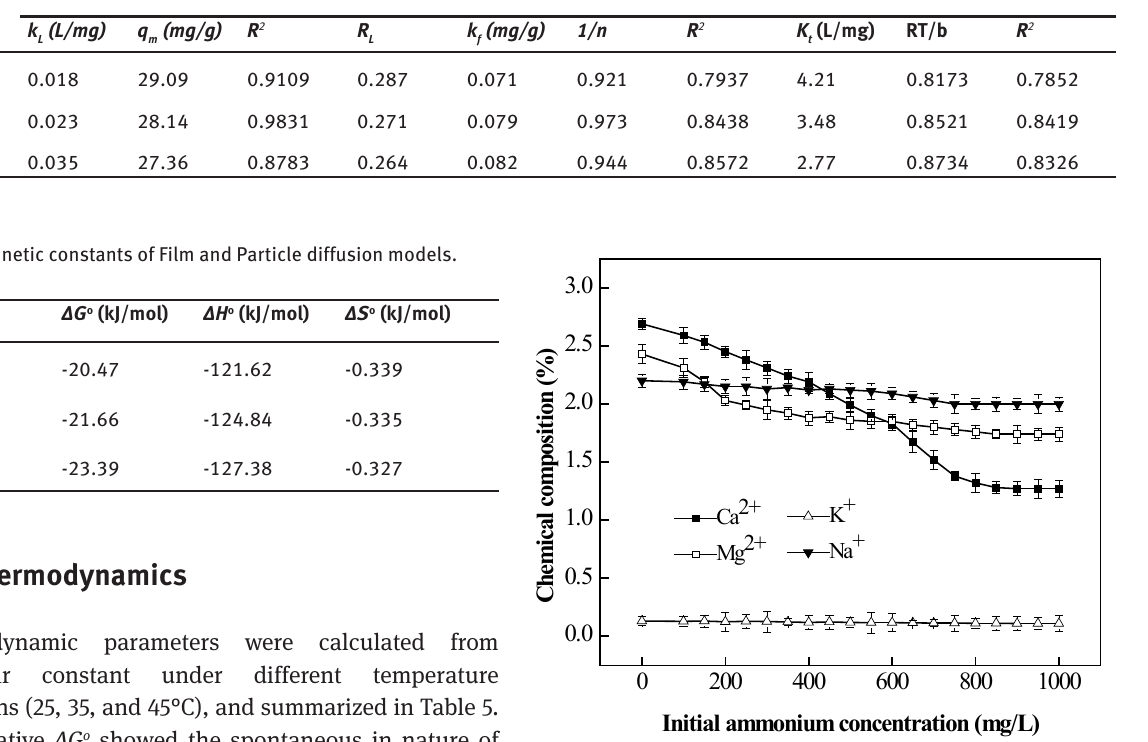
Table 4: Kinetic parameters of intraparticle diffusion model. T (°C) Langmuir isotherms Freundlich isotherms Tempkin isotherm